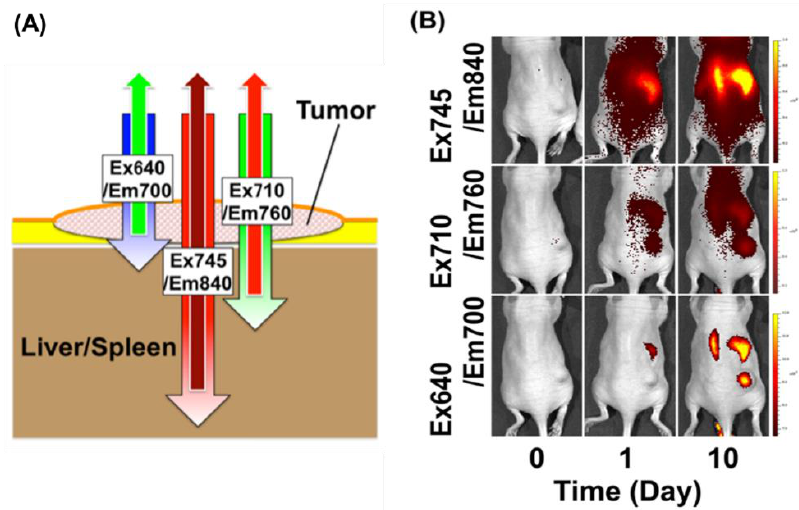
Figure 3. Depth-dependent NIR fluorescence in vivo imaging of a tumor. ( A ) A schematic illustration of depth-dependent NIR fluorescence imaging. Longer excitation and emission wavelengths, such as 745/840 nm (Ex745/Em850), can penetrate tissue very well and can detect particles in deeper sites, compared to shorter wavelengths (i.e., Ex710/Em760 and Ex640/Em700). ( B ) We administered totals of 2 mg (Day 1) and 6 mg (Day 10) of thiol-OS/IR820 into a mouse that had a subcutaneous xenograft tumor intravenously and observed the fluorescence using the in vivo imaging system under three excitation/emission wavelength conditions (Ex640/Em700 nm, Ex710/Em760 nm, and Ex745/Em840 nm). Reproduced with permission from Nakamura, M.; Hayashi, K.; Naka- Thiol-Organosilica Nanoparticles That are Functionalized with IR-820 and Their Applications for Long-Term Imaging of in Situ Labeled Cells and Depth-Dependent Tumor in Vivo Imaging. Chem.